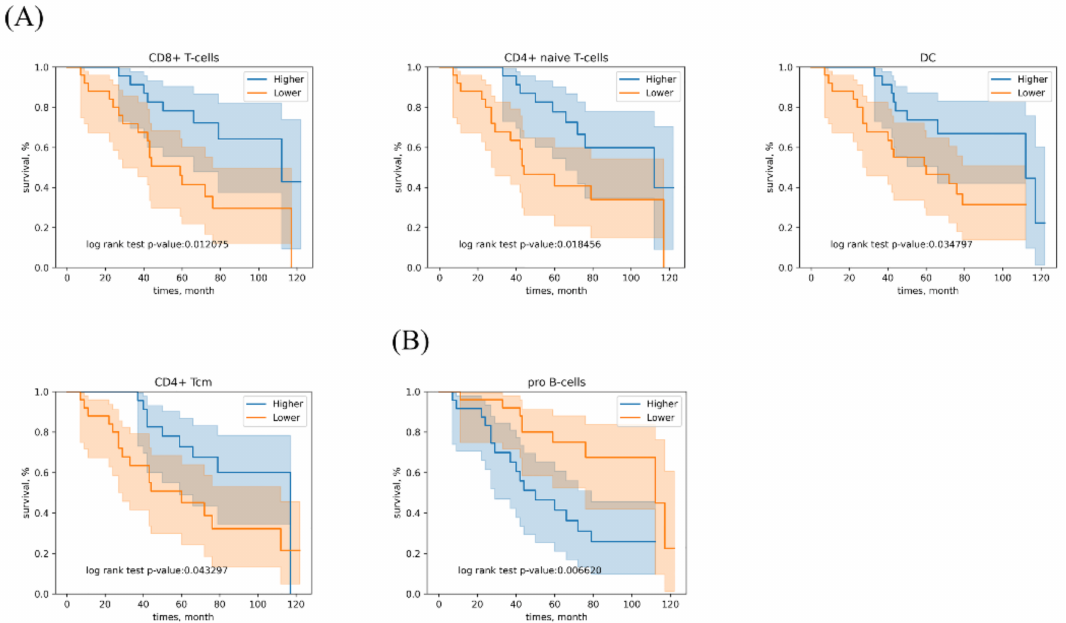
Figure 3. Kaplan-Meier plot showing overall survival (OS) according to immune cell types. ( A ) The group with high levels of CD8+ T-cells, CD4+ naive T-cells, DC and CD4+ Tcm exhibited significantly higher OS according to the log-rank test. ( B ) The group with high levels of pro B-cells showed significantly reduced OS.